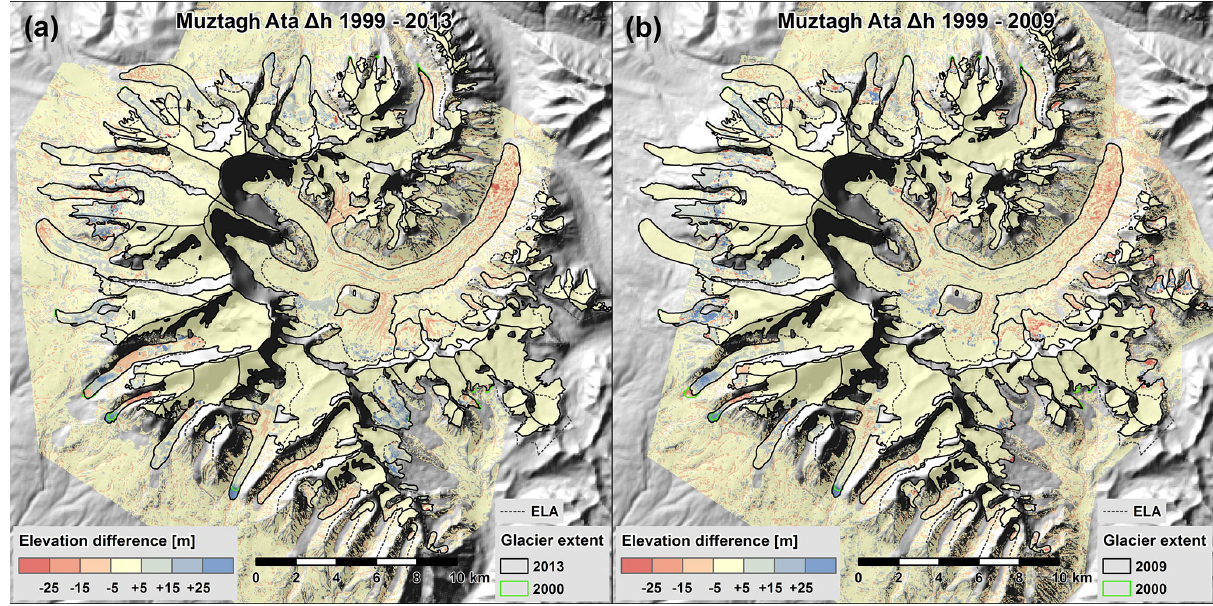
Figure 8. Co-registered map of elevation differences during 1999–2013 (a) and 1999–2009 (b) after outlier and gap-filling processing for glacier mass-balance and vertical uncertainty